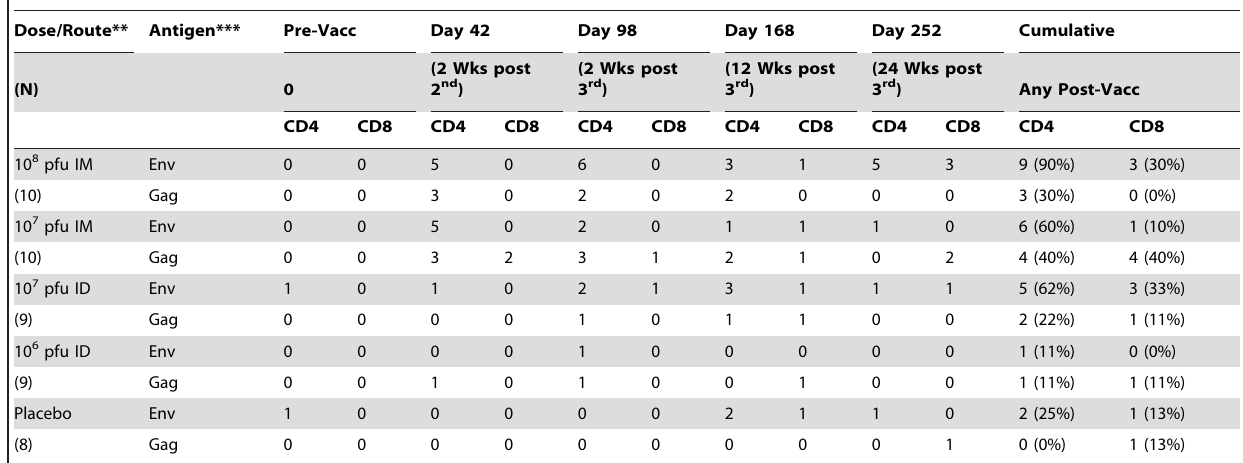
Table 4. Cross-sectional vaccine responsiveness by Whole Blood ICS